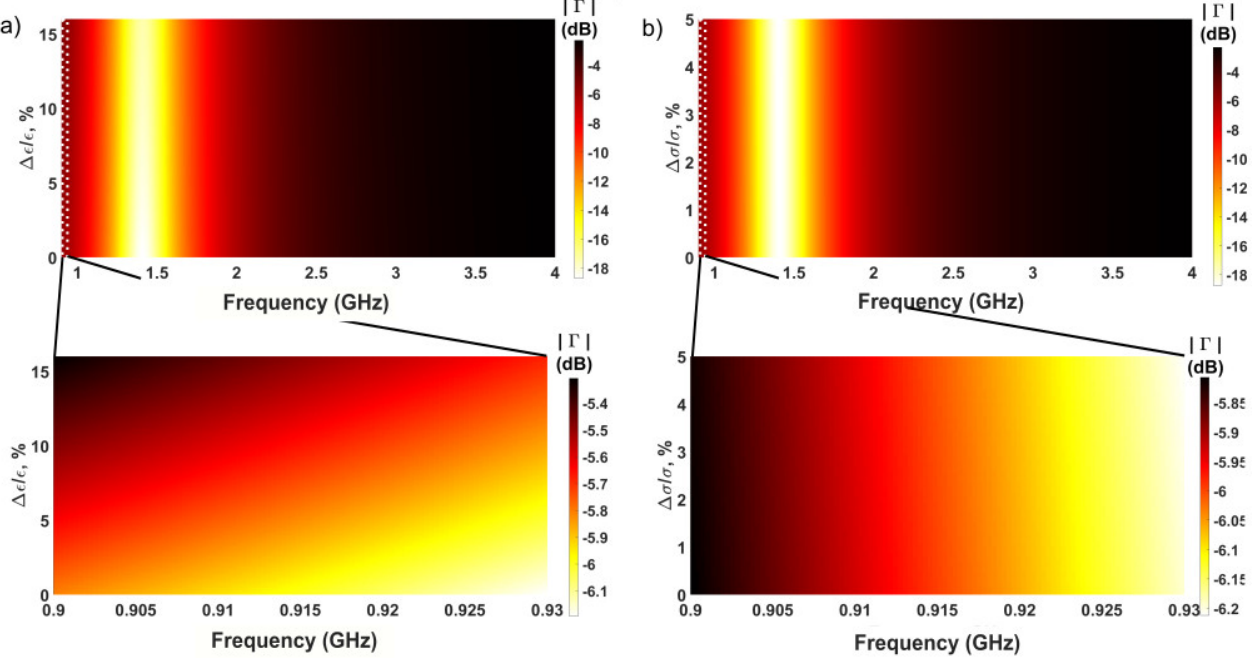
Figure 5. ( a ) Magnitude of the reflection coefficient ( Γ ) vs. frequency for the variation of the dielectric permittivity of the pituitary tumor with respect to its average value ( ∆ (cid:101) / (cid:101) ). ( b ) Magnitude of the reflection coefficient ( Γ ) vs. frequency, for the variation of the electrical conductivity of the pituitary tumor with respect to its average value ( ∆ σ / σ